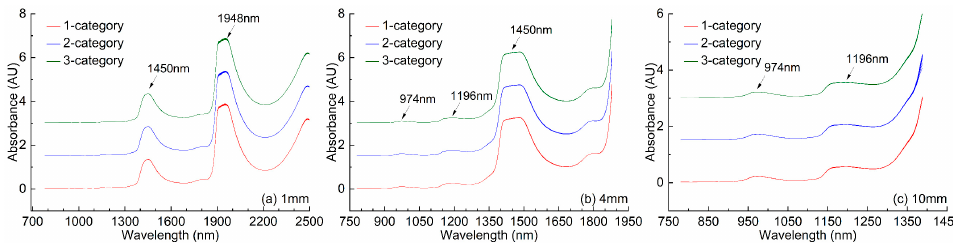
Figure 1. Spectra in desaturated wavebands of three groups of water samples based on three measurement modals: ( a ) 1 mm, ( b ) 4 mm, ( c ) 10 mm.